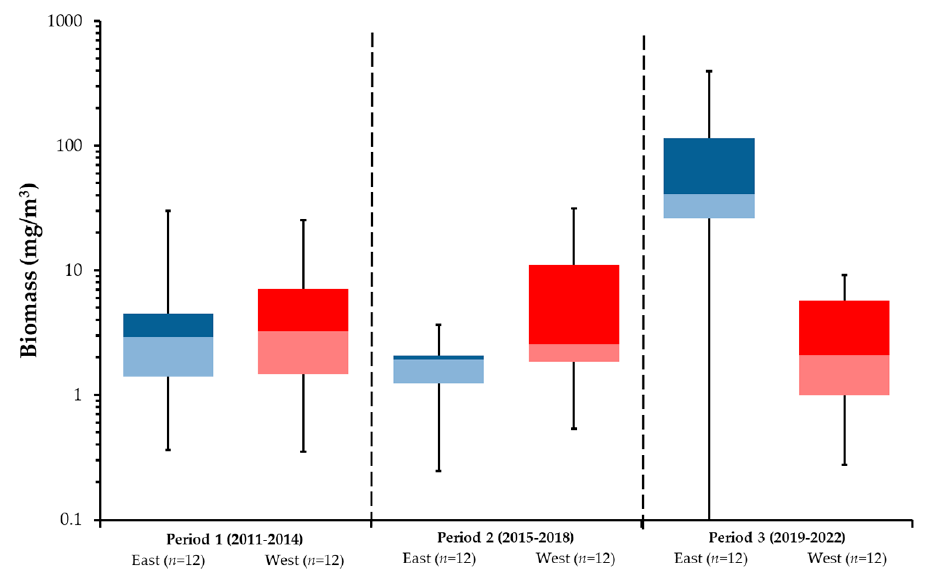
Figure 3. Boxplot of invertebrate biomass (per period) in the eastern ( (cid:4) ) and western ( (cid:4) ) sections of DWDS Zeeuws-Vlaanderen.